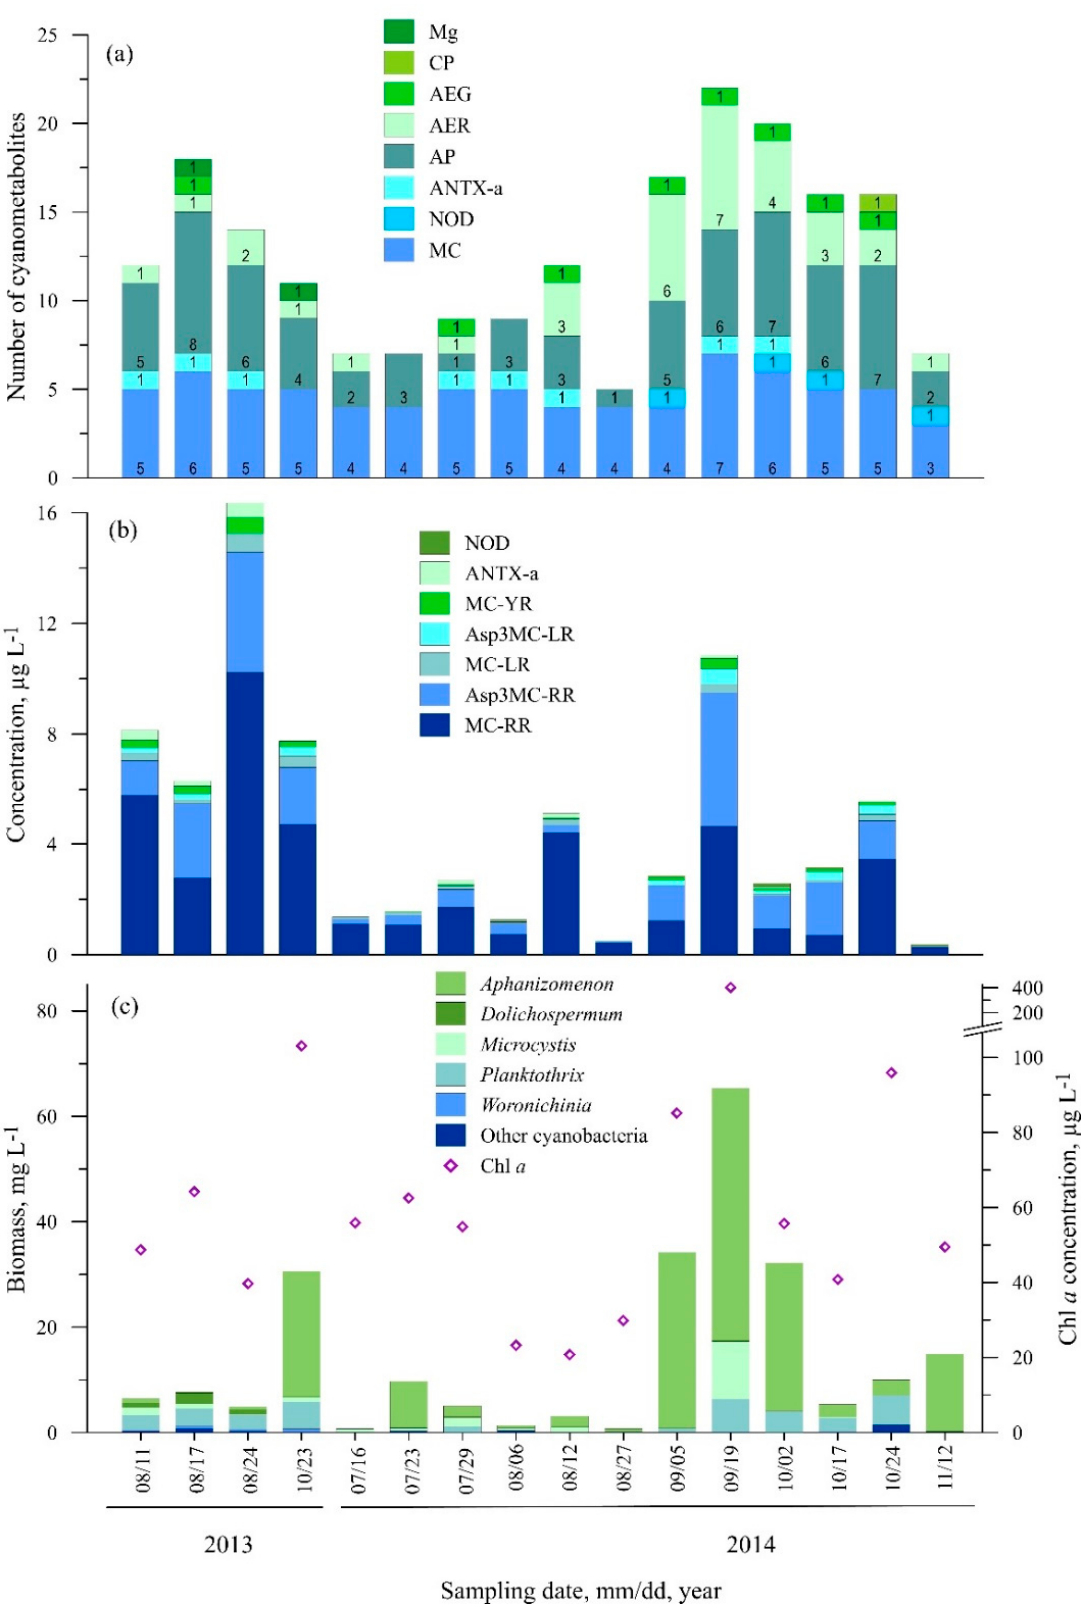
Figure 4. Seasonal changes in the number of cyanometabolites ( a ), concentration of microcystin and anatoxin variants ( b ), cyanobacteria biomass and Chl a concentration ( c ) at St. 2.